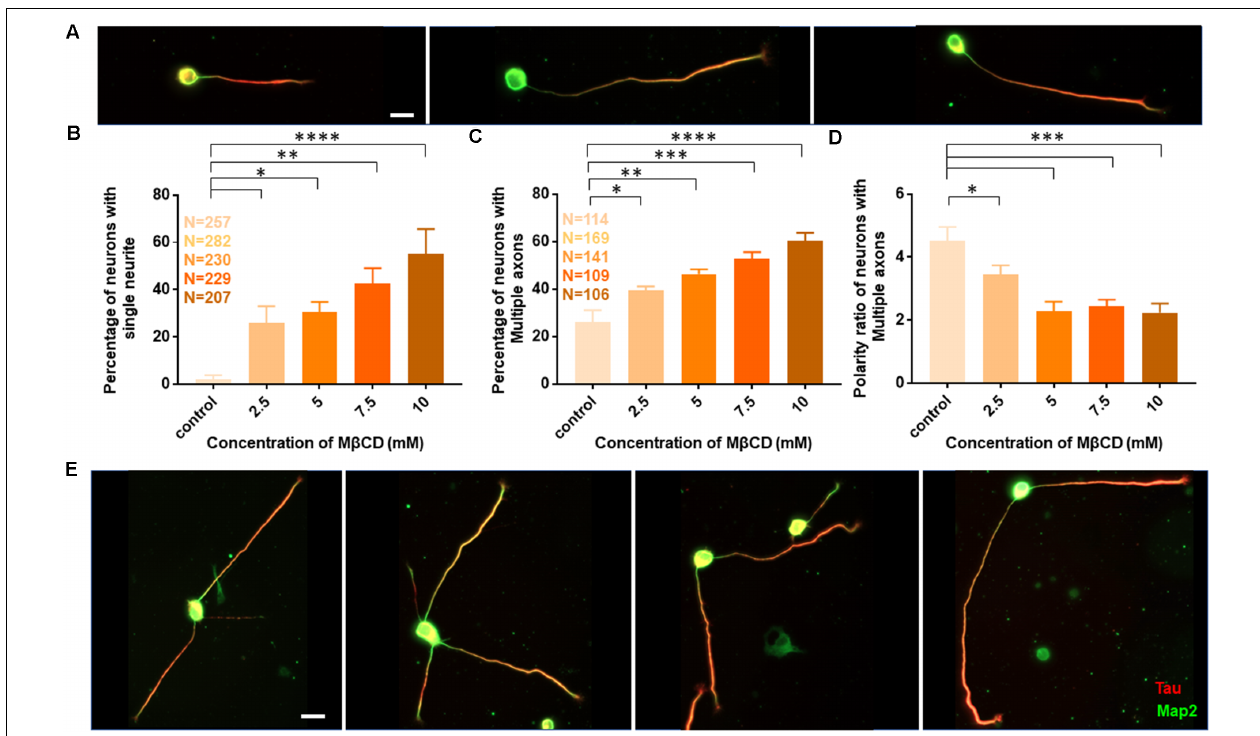
FIGURE 3 | Transient cholesterol sequestering affects neuronal arborization and polarity. (A) A gallery of neurons treated with M β CD for 10 min, exhibiting single neurites, is presented. (B) Percentage of cells with single neurites upon application of varying concentrations of M β CD. (C) Percentage of cells with supernumerary axons upon application of varying concentrations of M β CD for 10 min. (D) Polarity ratio of neurons exhibiting supernumerary axons as calculated from (C) . (E) A gallery of treated neurons displaying supernumerary axons is presented. Cholesterol sequestered neurons treated with M β CD displayed single neurites and multiple axons, exhibiting a severe shift in neuronal polarity. The polarity ratio was significantly reduced in neurons exhibiting multiple axons, showing symmetric growth for the affected cells. N denotes the number of cells from five independent cultures for (B) and from three independent cultures for (C,D) . One-way Anova was performed to test the significance of the difference between the means. ∗∗∗∗ p < 0.0001, ∗∗∗ p < 0.001, ∗∗ p < 0.01, ∗ p < 0.05. Scale bar indicates 20 µ